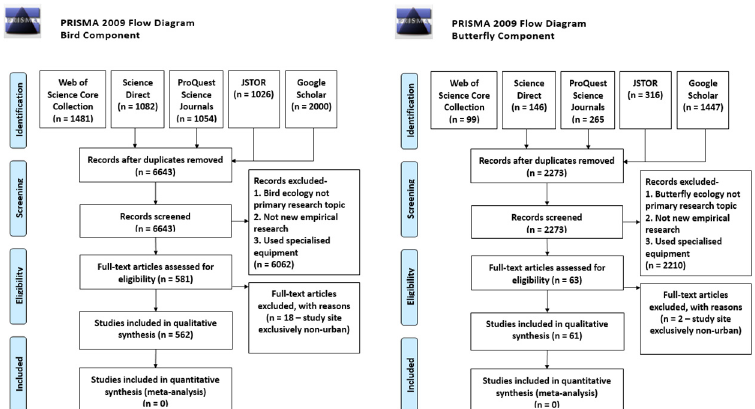
Fig 1. PRSIMA flowchart summarising the workflow adopted in this systematic review.